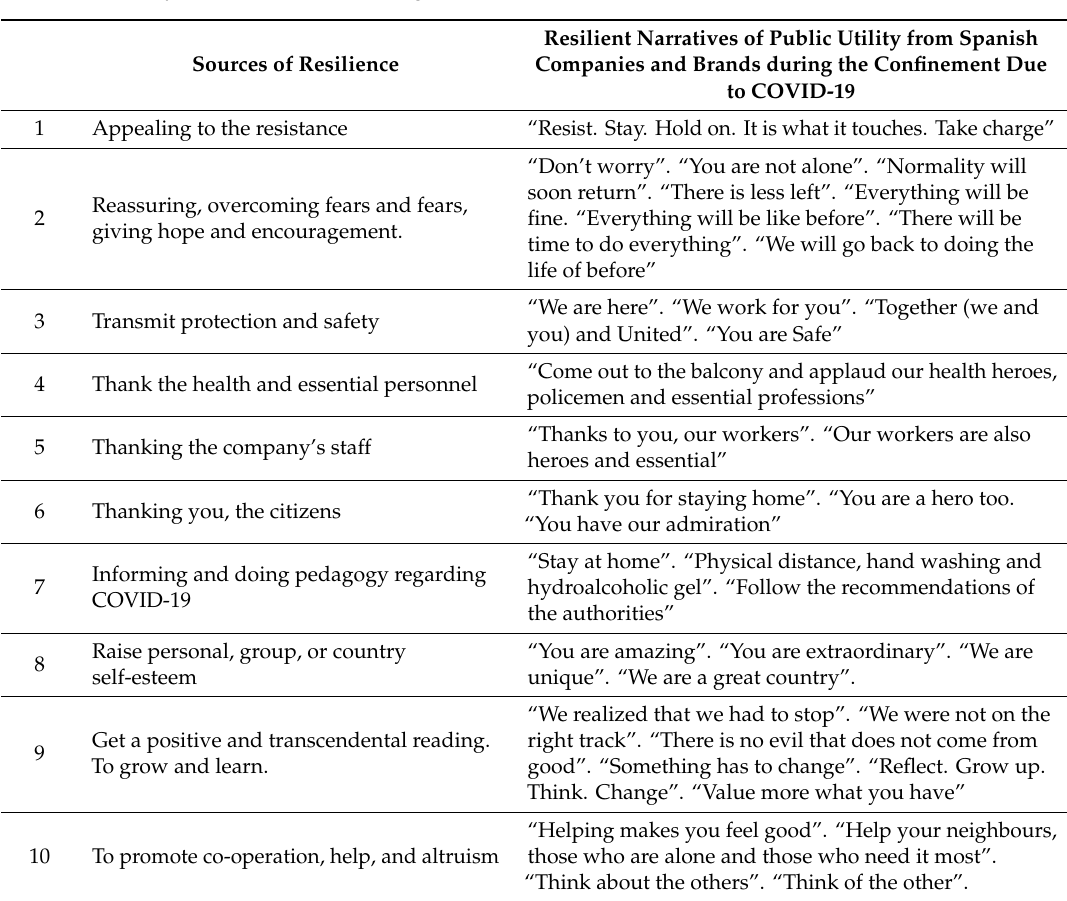
Table 4. Sources of resilience in brand advertising messages. Source: Own elaboration from Connor [35], Walsh [38], Cyrulnik [36], and Grotberg